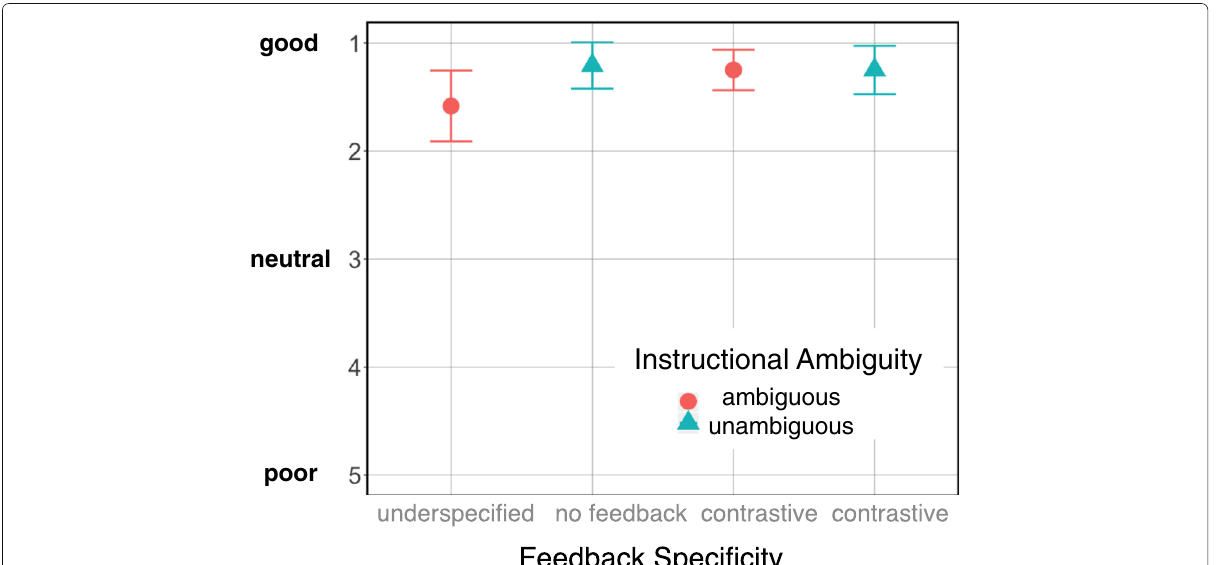
Fig. 6 Mean responses for “How good did you find the interaction flow?” for Experiment 1 on a five-point Likert scale, where 1 indicates a good/positive rating and 5 a poor one. (95% confidence interval error bars)